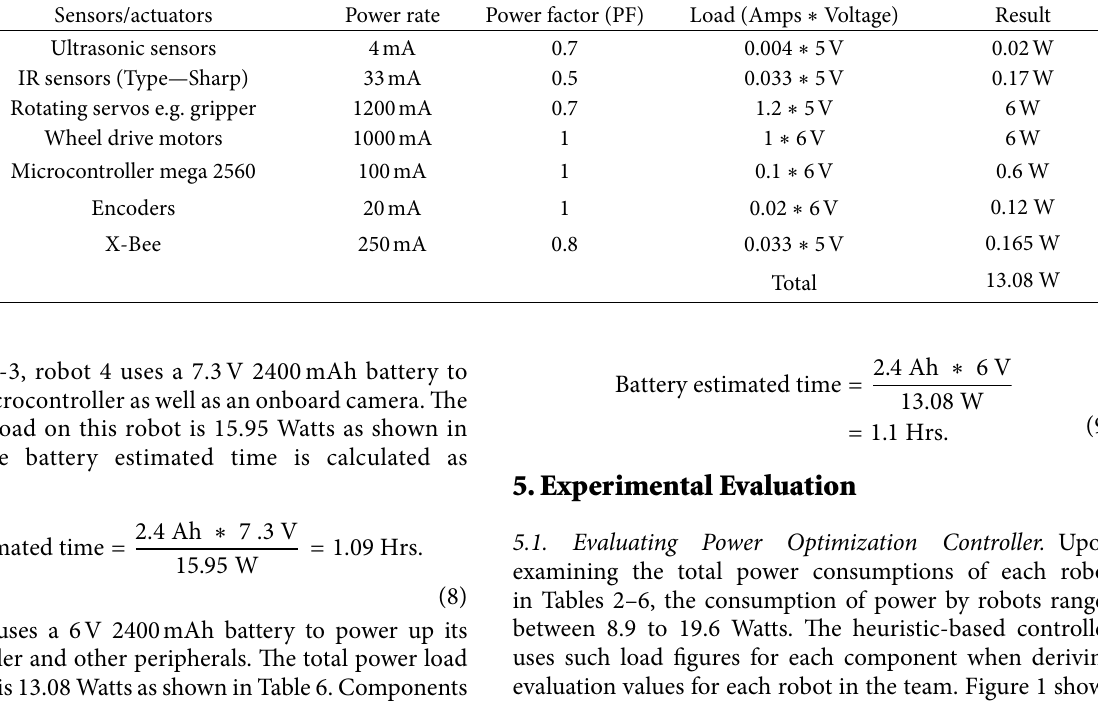
Table 6: Components and loads in robot